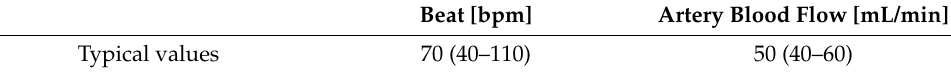
(Figure 2). In the natural situation, the blood flow in the parent artery ( F + F 1 ) is not so different before and after aneurysmal formation. To realize this feature, the amount of artery blood flow is adjusted by choosing the value of R , and the resistance parameter R is fixed to R = 2.2 for all of the systematic calculations. Table 1. Parameters in realistic situations, which are actually adopted in the present calculation. As a result, the frequency f in this paper is fixed to 70/60 (1/sec), and the artery blood flow F to 50 (mL/min).